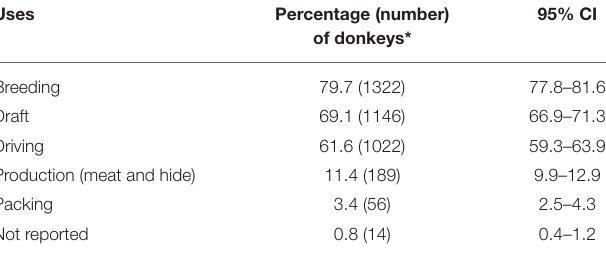
TABLE 3 | Uses of donkeys across smallholder farms in Western Liaoning and Eastern Inner Mongolia of China ( n = 1,658).